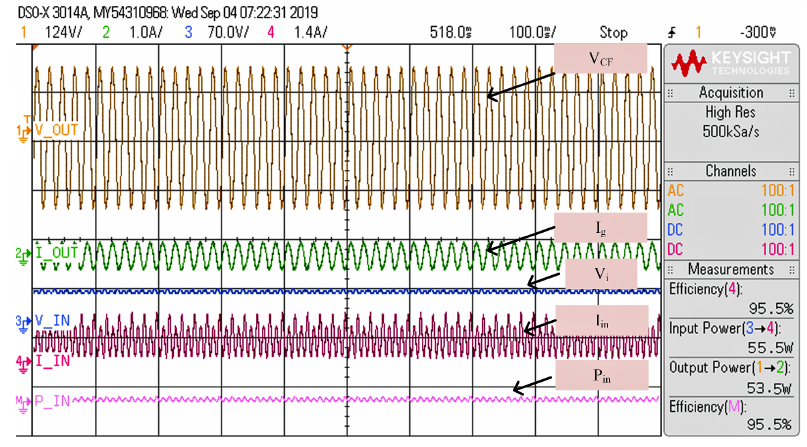
Figure 22. Input and output voltage and current with efficiency at 800 W/m 2 .